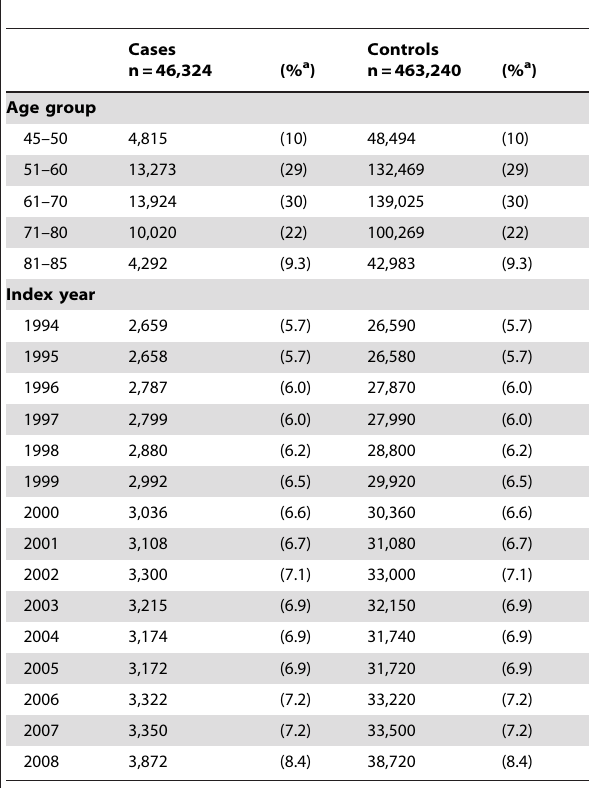
Table 1. Frequencies and proportions of breast cancer cases and controls by age group and index years of diagnosis.